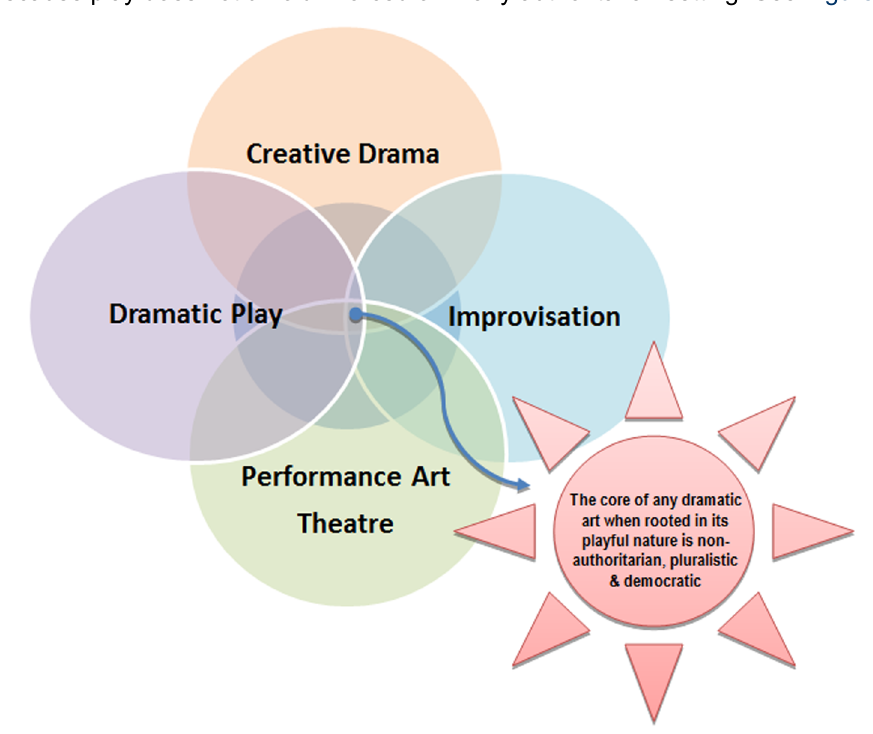
Figure 1. The transformational qualities of dramatic